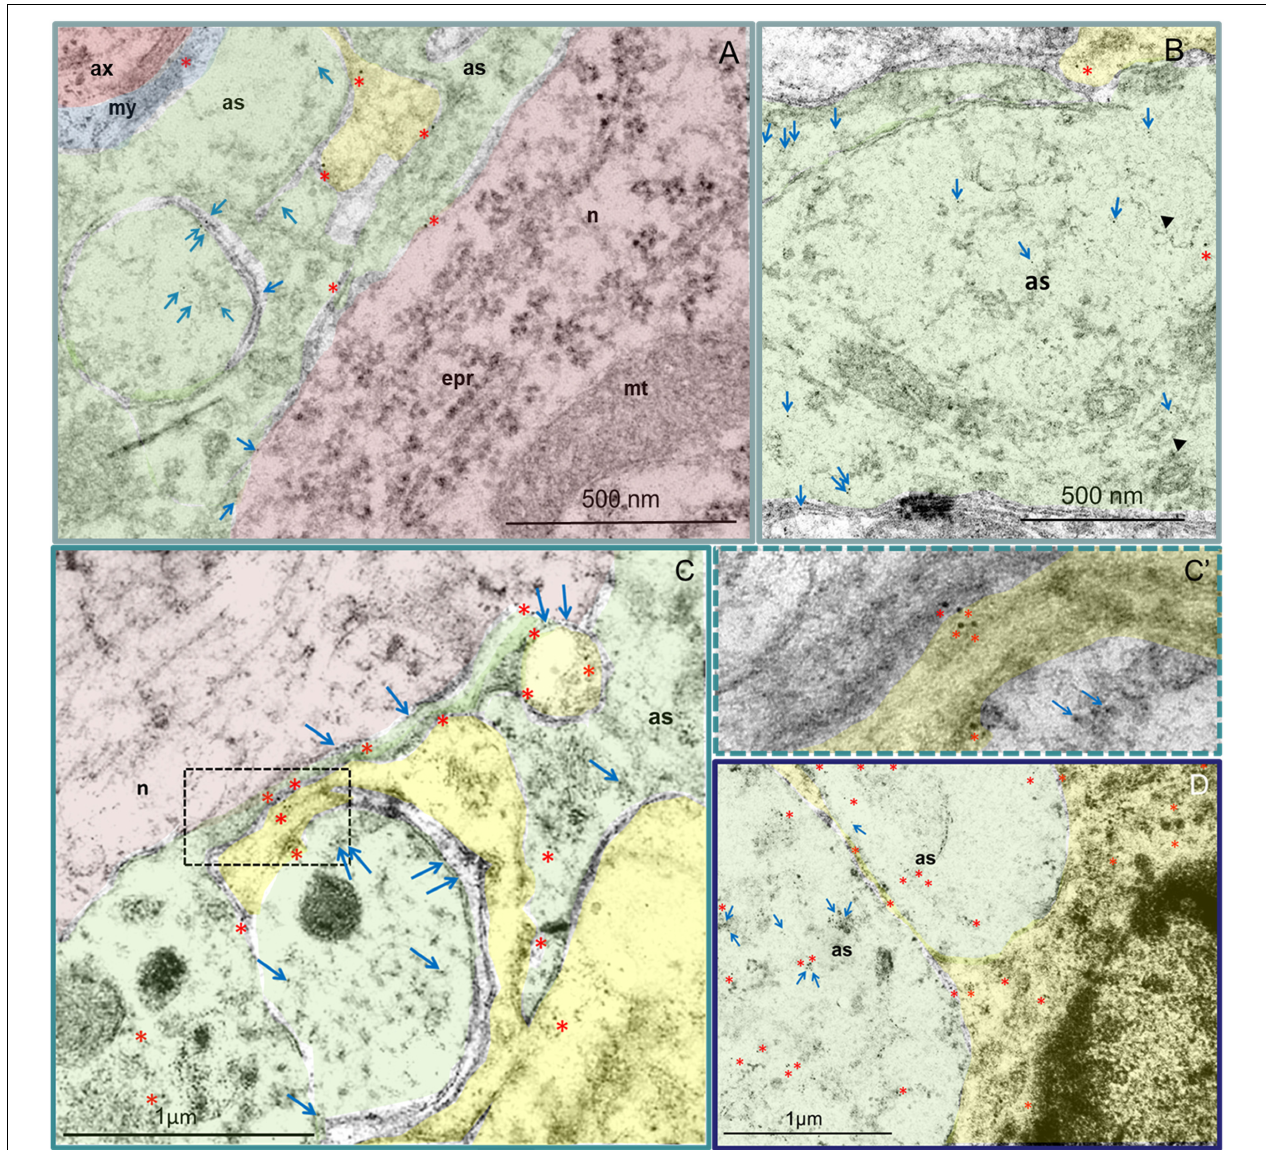
FIGURE 3 | Astrocytes (green) and NG2 + (yellow) cells in the VH. Immunoelectron microscopic images of intact (A,B) and injured spinal cord 30 dpi 3–5 mm (C) and 6–8 mm (D) caudally from the epicenter. Asterisks denote 10 nm golden nanoparticles (anti-NG2 antibody) and arrows highlight 5 nm golden nanoparticles (anti-ALDH1L1 antibody). (A) In the VH of the intact spinal cord, a positive reaction to NG2 proteoglycan was detected in the cytoplasm of oligodendrocytes and myelin membranes, as well as in a small amount along the plasma membranes in the processes of astrocytes, including those adjacent to the neuron. In NG2 + glia, the ALDH1L1 immunopositive reaction was not observed. (B) High ALDH1L1 immunoreactivity was found in the cytoplasm of astrocytes. The belonging of cells to astrocytes can be estimated by the presence in the cytoplasm of characteristic lumps of average electron density and filaments 15 nm in diameter (head arrow). (C) At 30 dpi, the distributions of NG2 proteoglycan and ALDH1L1 were similar to those of the intact spinal cord. At the same time, the expression of NG2 proteoglycan in NG2 + glial cells, oligodendrocytes (C) , and reactive astrocytes (D) was visually more intense. Higher-magnification view of the dashed boxed area in the (C (cid:48) ) . as – astrocyte; ax – axon; epr – endoplasmic reticulum; mt – mitochondria; my – myelin; n – neuron. Scale bar: 500 nm (A,B) and 1 µ m (C,D)